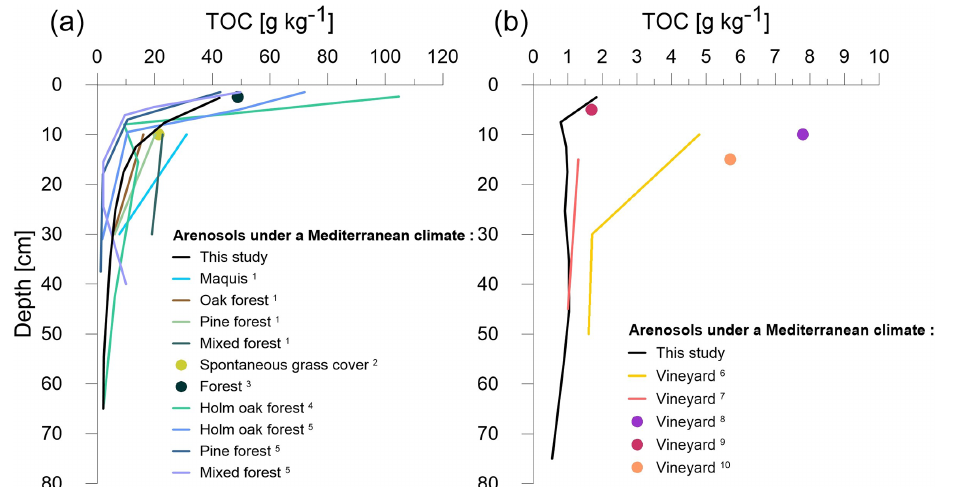
Figure 3. TOC comparison between the Brugassières Arenosol and other forest Arenosols (a) and vineyard Arenosols (b) under a Mediter- ranean climate. (1) Pinzari et al. (1999); (2) Caravaca et al. (2002); (3) Fierro et al. (2007); (4) Andreetta et al. (2013); (5) Vittori Antisari et al. (2016); (6) Conradie (2001); (7) Fourie et al. (2005); (8) Okur et al. (2009); (9) López-Piñeiro (2013); (10) Nogales et al. (2019). Data are available in Table E1 (with details about Mediterranean climate in Table